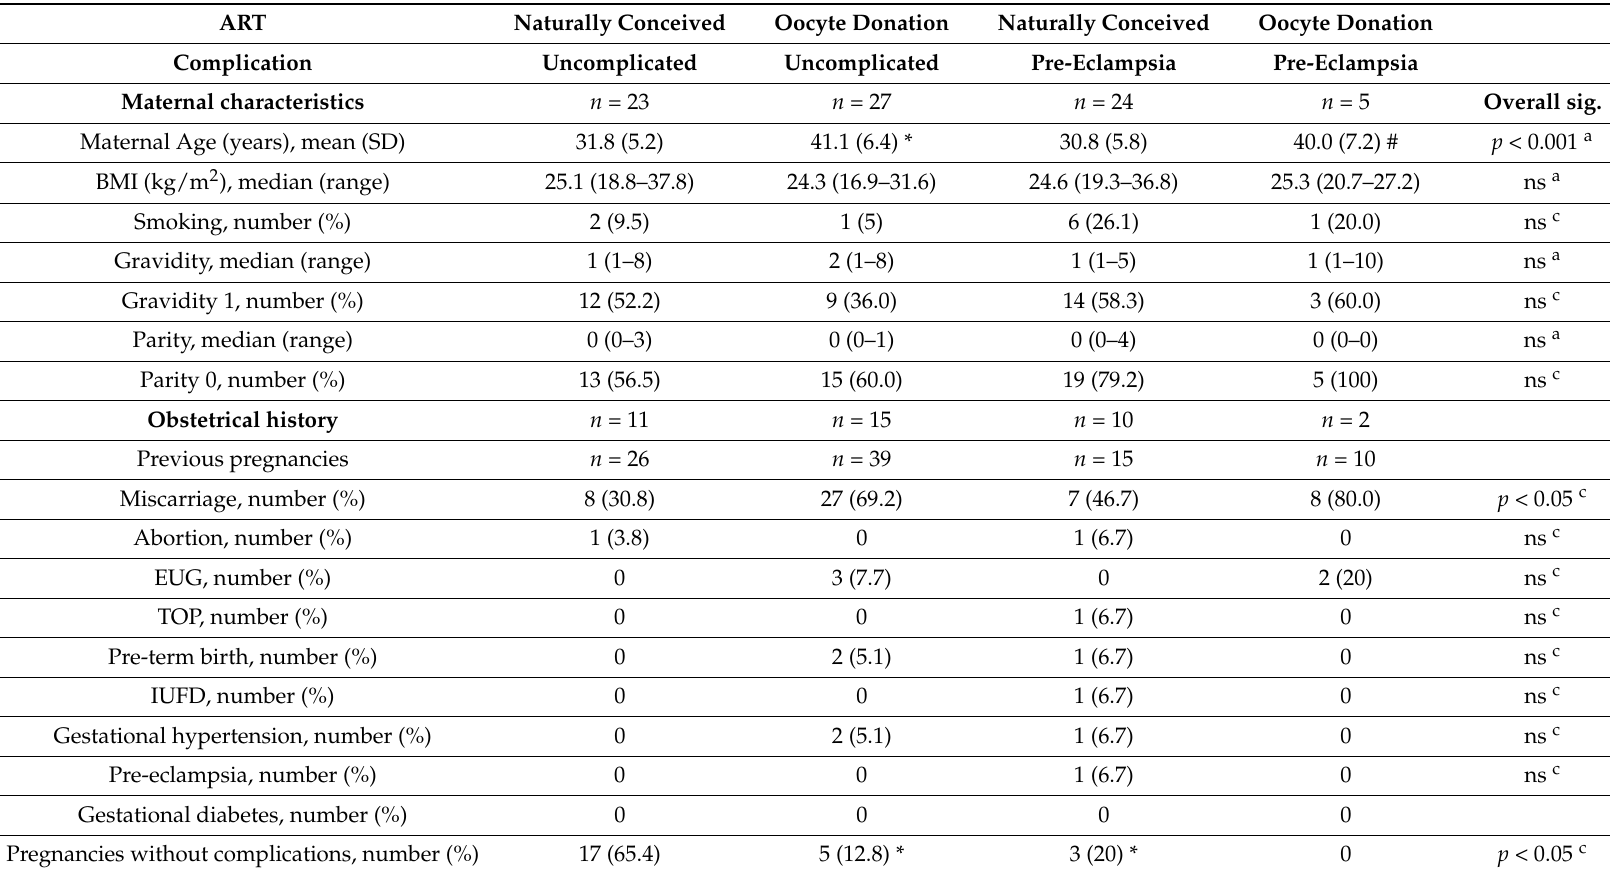
Table 1. Patient characteristics, obstetrical history, pregnancy characteristics and fetal